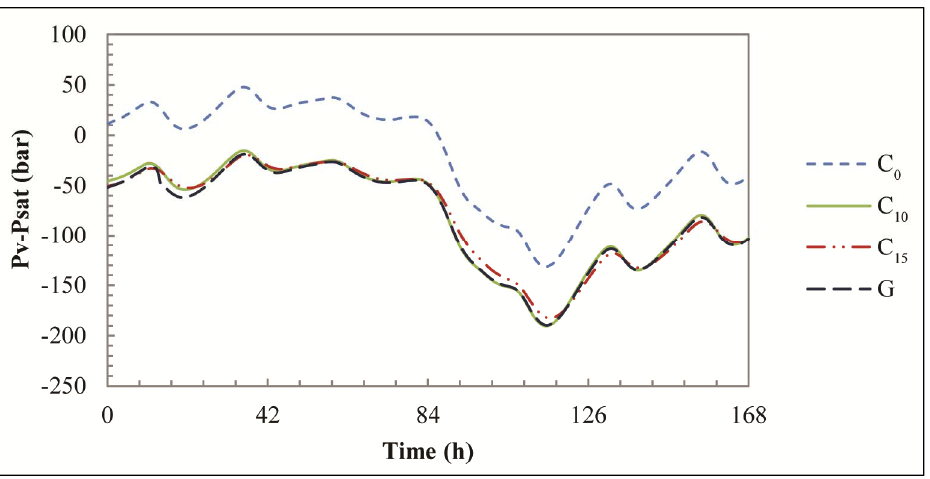
Figure 17. Partial pressure of vapor minus saturation pressure of water in correspondence of the column during the simulated